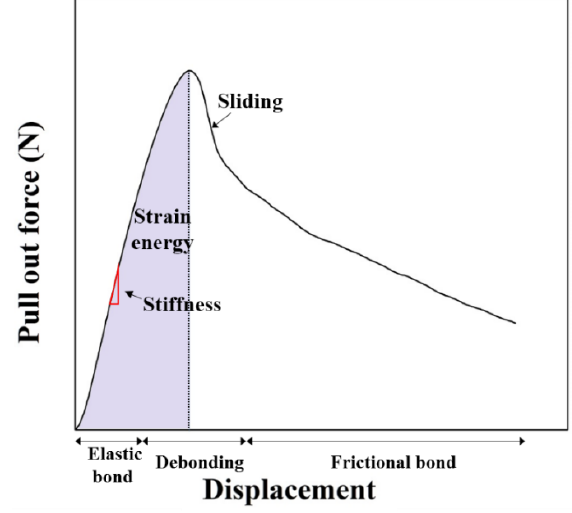
Figure 4. Pullout force–displacement curve of pedicle screws with ( a ) grade 10 and ( b ) grade 20.